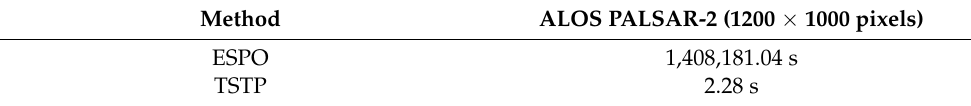
Table 3. Cost Time Comparison Between Different Polarimetric Optimization